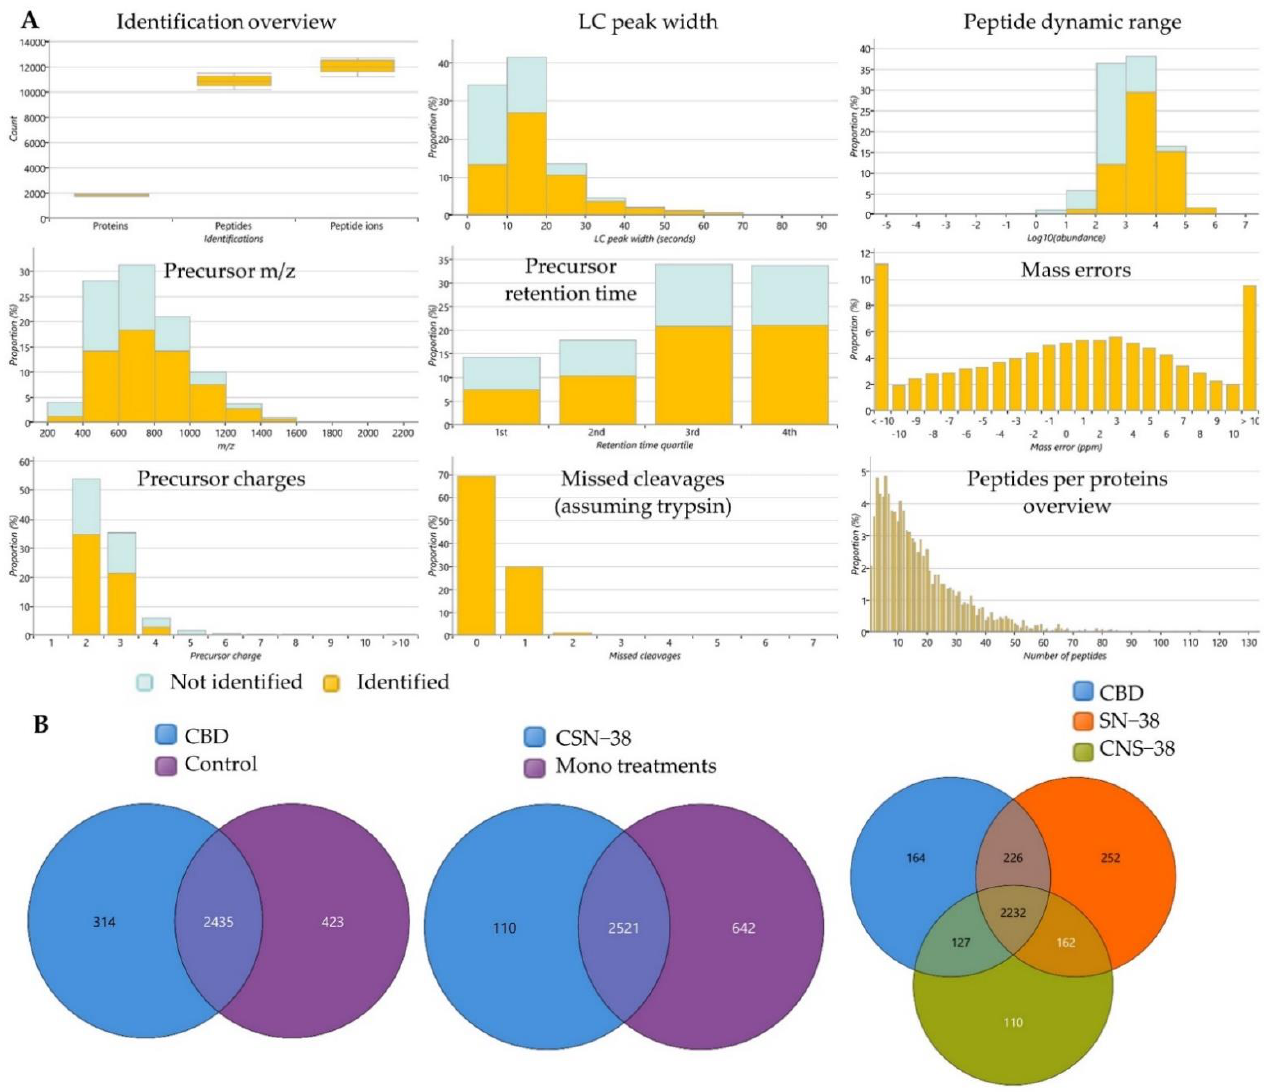
Figure 6. Label-free quantification proteomics study of cannabidiol (CBD) synergistic combination with SN−38 in MCF7 cells. ( A ) Overview of quality control metrics for the label-free quantification proteomics study showing peptides and protein counts, peptide charges, missed cleavage (approximately 70% of the identified peptides showed zero missed cleavage), most of the peptides eluted in the 3rd and 4th quartiles of the LC run, peak width, identified peptides per proteins, and mass errors proportions in the identified peptides. ( B ) Venn diagrams of the overlapped identified proteins’ counts in the differently treated groups. CSN−38 = synergistic combination of CBD and SN−38; control = vehicle (0.5% DMSO)-treated MCF7 cells.